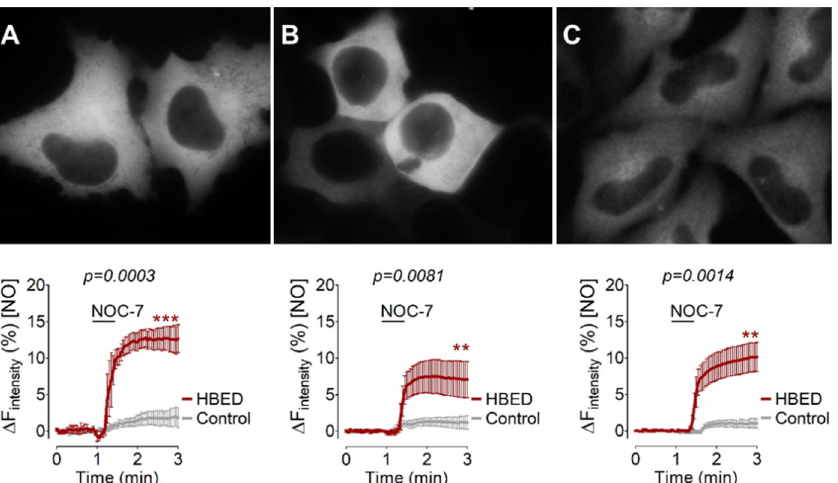
Figure 1. NO biosensor reports labile iron (II) in a concentration-dependent manner. ( A ) The cartoon shows iron (II) dependency of the NO biosensor geNOps. If iron salts are provided to cells, only ferrous iron can enter the cell cytosol through DMT1 channels but not ferric iron. Non-heme iron consisting of geNOps can sense NO in an iron (II)-concentration-dependent manner. ( B ) Average curves show real-time NO signals in response to 10 µM NOC-7 in HEK293T cells expressing O-geNOps. Cells have been treated with equimolar concentrations of FeSO 4 and Vitamin C, respectively, for 20 min before imaging experiments: 500 µM (black curve, n = 3/60), 300 µM (dark grey curve, n = 3/54), 100 µM (green curve, n = 3/56), 30 µM (blue curve, n = 3/42), and control no treatment (light grey curve, n = 3/73). ( C ) Bars represent the statistical analysis of iron (II) dependent geNOps responses shown in panel b. All values are given as ±SD, and Dunnet’s multiple comparison test was applied. ** 0 vs. 30 um, Mean Difference (Diff): − 5.525, q = 5.182, 95% Confidential Interval (CI) of Diff: − 8.607 to − 2.443; *** 0 vs. 100 um; Mean Diff: − 9.870; q = 9.257, 95% CI of Diff: − 12.95 to − 6.79; *** 0 vs. 300 um; Mean Diff: − 11.400; q = 10.69, 95% CI of Diff: − 14.48 to − 8.32; *** 0 vs. 500 um; Mean Diff: − 13.800; q = 12.94, 95% CI of Diff: − 16.88 to − 10.71.